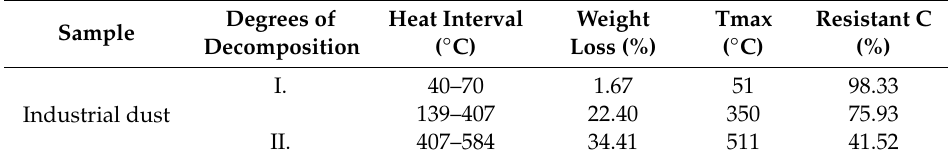
Table 2. Temperature characterization of individual degrees of decomposition of industrial dust sample by thermogravimetric (TG) analysis.